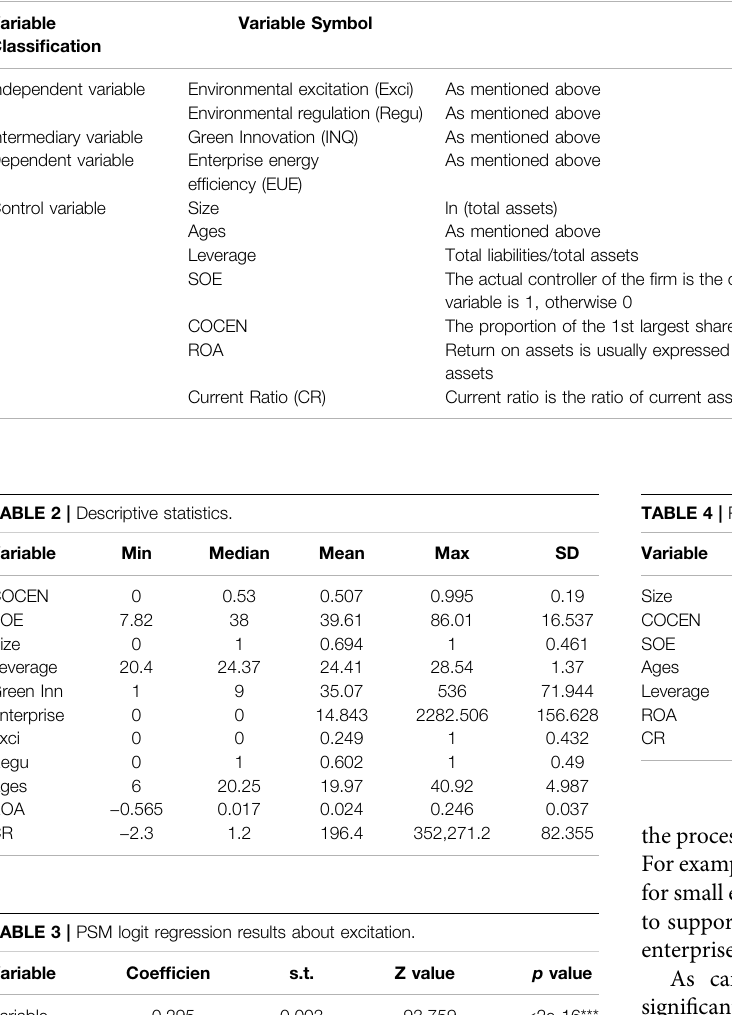
TABLE 1 | Variables and de fi nition.